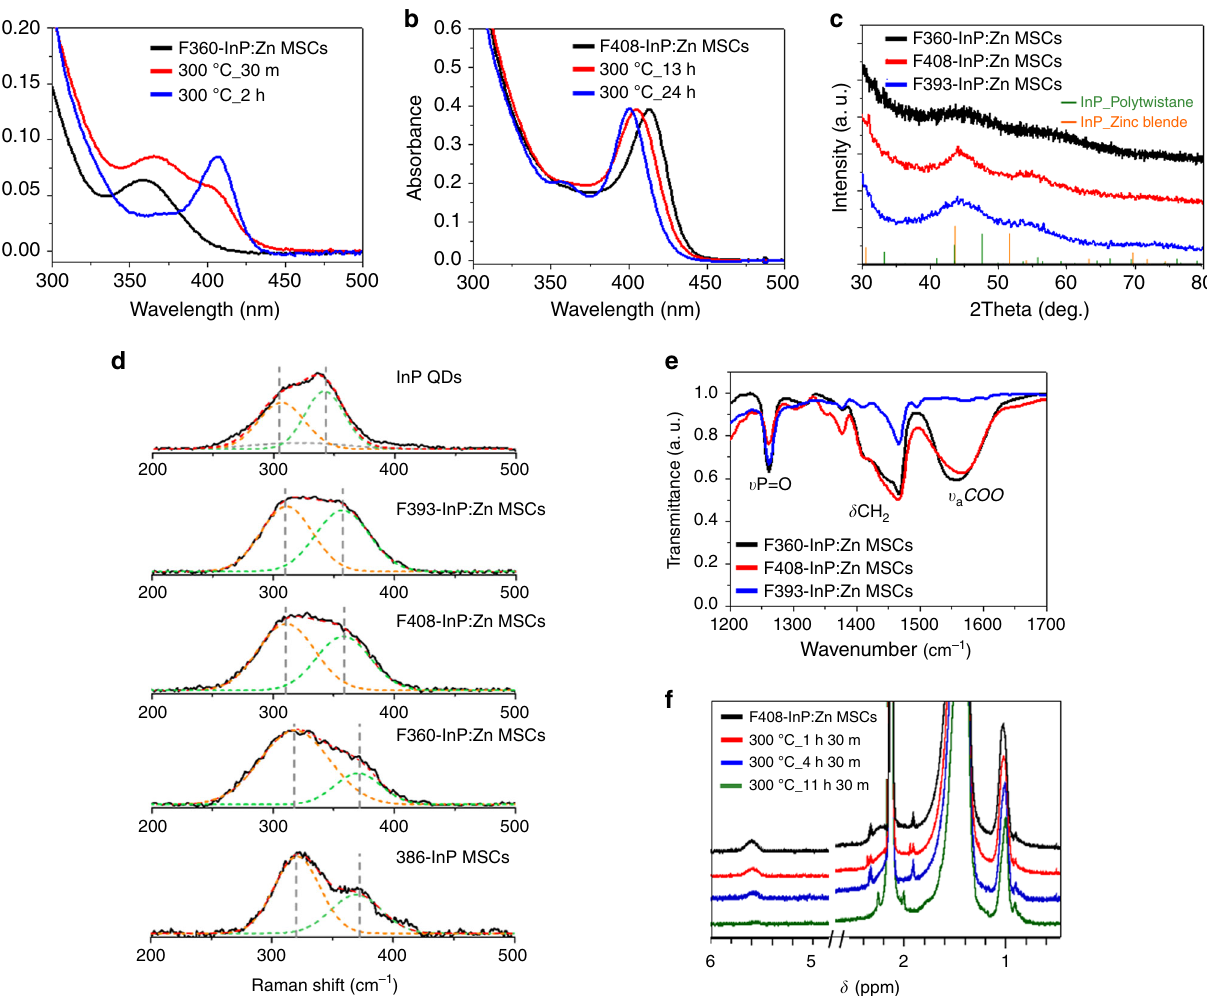
Fig. 8 Conversion syntheses and characterizations of InP:Zn MSCs. UV − vis absorption spectra of aliquots taken during a conversion synthesis of F408- InP:Zn MSCs from as-synthesized F360-InP:Zn MSCs and during b conversion synthesis of F393-InP:Zn MSCs from as-synthesized F408-InP:Zn MSCs. c XRD patterns of F360-InP:Zn MSCs, F408-InP:Zn MSCs, and F393-InP:Zn MSCs. JCPDS diffraction fi le No. 32-0452 was used for zinc-blende InP. The XRD pattern of polytwistane phase was obtained from a previous publication 25 . d Raman spectra of InP QDs with zinc-blend structure, F393-InP:Zn MSCs, F408-InP:Zn MSCs, F360-InP:Zn MSCs, and 386-InP MSCs. e FTIR spectra of F360-InP:Zn MSCs, F408-InP:Zn MSCs, and F393-InP:Zn MSCs. f 1 H NMR spectra of aliquots taken during conversion synthesis of F393-InP:Zn MSCs from F408-InP:Zn MSCs.